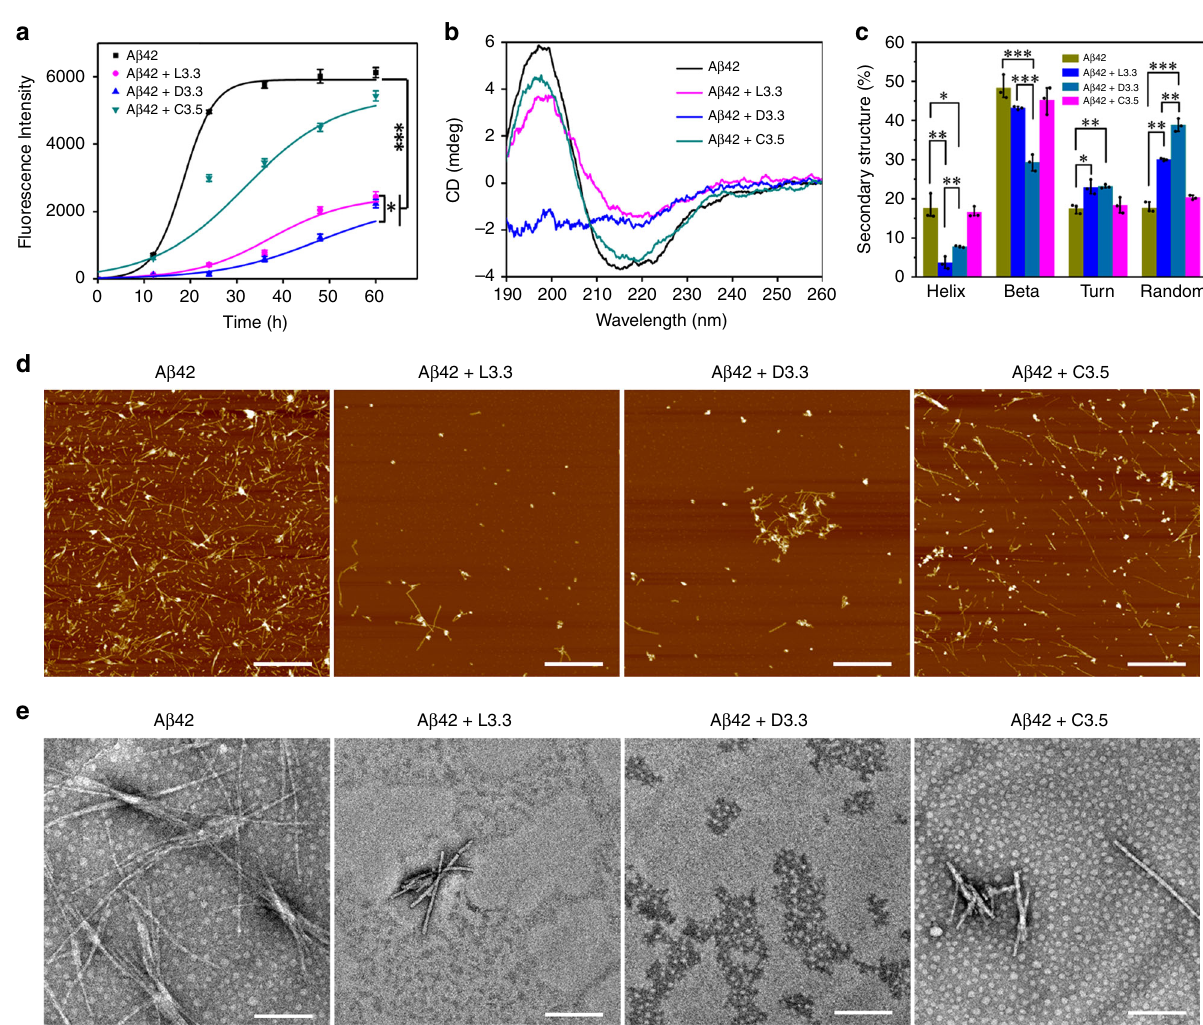
Fig. 1 Effect of L3.3, D3.3, and C3.5 on A β 42 fi brillization in vitro. a ThT fl uorescence assay of A β 42 in the absence and presence of 3.3-nm L-GSH capped Au nanoparticles (denoted as A β 42 + L3.3), 3.3 nm D-GSH capped Au nanoparticles (abbreviated as A β 42 + D3.3), or 3.5 nm citrate-capped Au nanoparticles (denoted as A β 42 + C3.5). The fi brillation kinetics is fi tted with a sigmoidal function. b CD spectra of A β 42 (40 μ M) in the absence and presence of L3.3, D3.3, or C3.5 (110 nM) after co-incubation for 48 h. c Analysis of protein secondary structure. d AFM images of A β 42 (40 μ M) in the absence and presence of L3.3, D3.3, or C3.5 (110 nM) after co-incubation for 48 h. Scale bars, 1 μ m. e TEM images of A β 42 (40 μ M) in the absence and presence of L3.3, D3.3, or C3.5 (110 nM) after co-incubation for 48 h. Scale bars, 200 nm. Error bars indicate the s.d. ( n = 3 independent samples). * P < 0.05, ** P < 0.01, *** P < 0.001, two-sided Student ’ s t test. For detailed statistical analysis see Supplementary Tables 6 and 7. Source data are provided as a Source Data fi